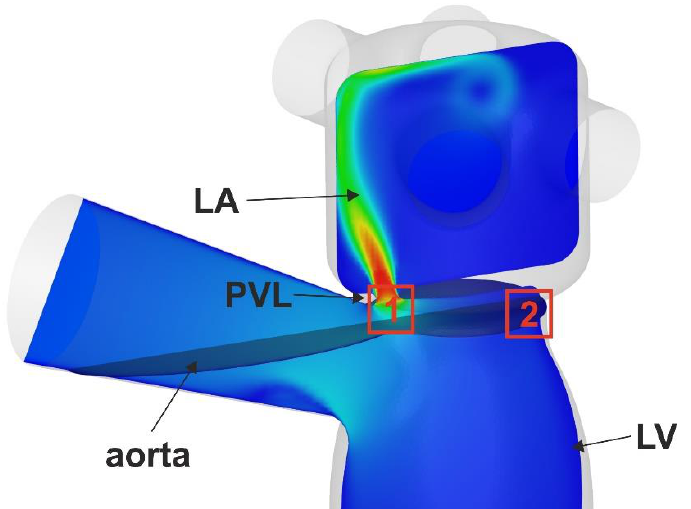
Figure 12. Velocity distribution in the model of the left ventricle, left atrium and PVL channel. Boxes 1 and 2 correspond to anterior (PVL I, III, IV) and posterolateral (PVL II) locations, respec- tively.